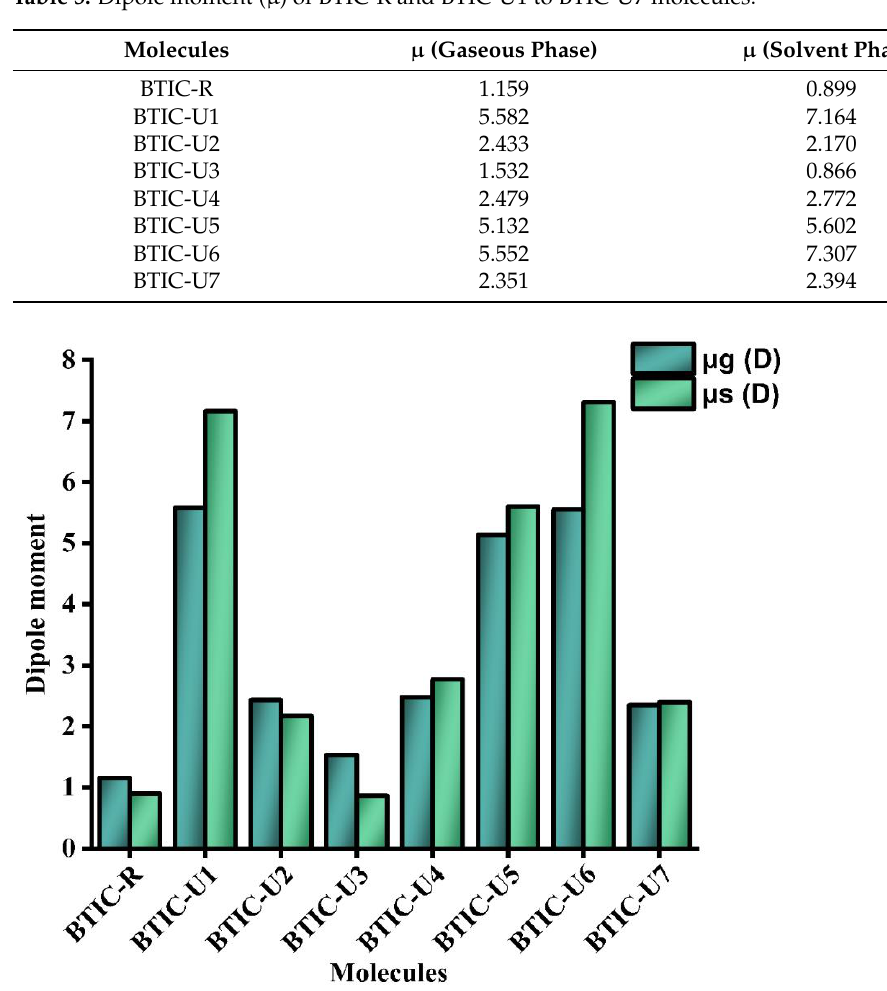
Figure 6. Graphical illustration of Dipole moment in the gas phase and solution.